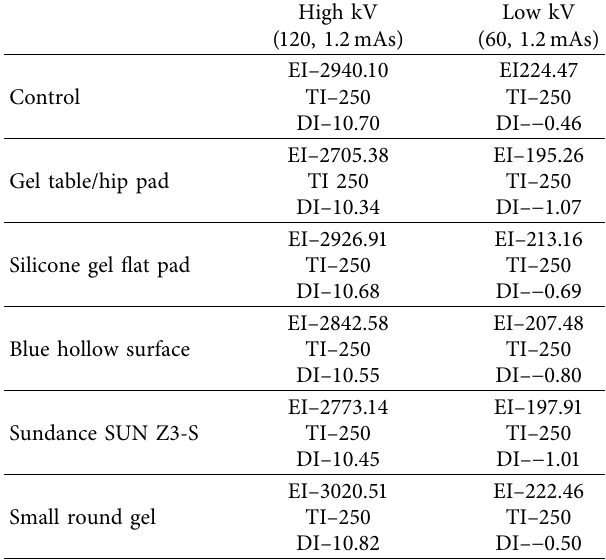
Table 3: Exposure and deviation indices for the surface overlays at high and low